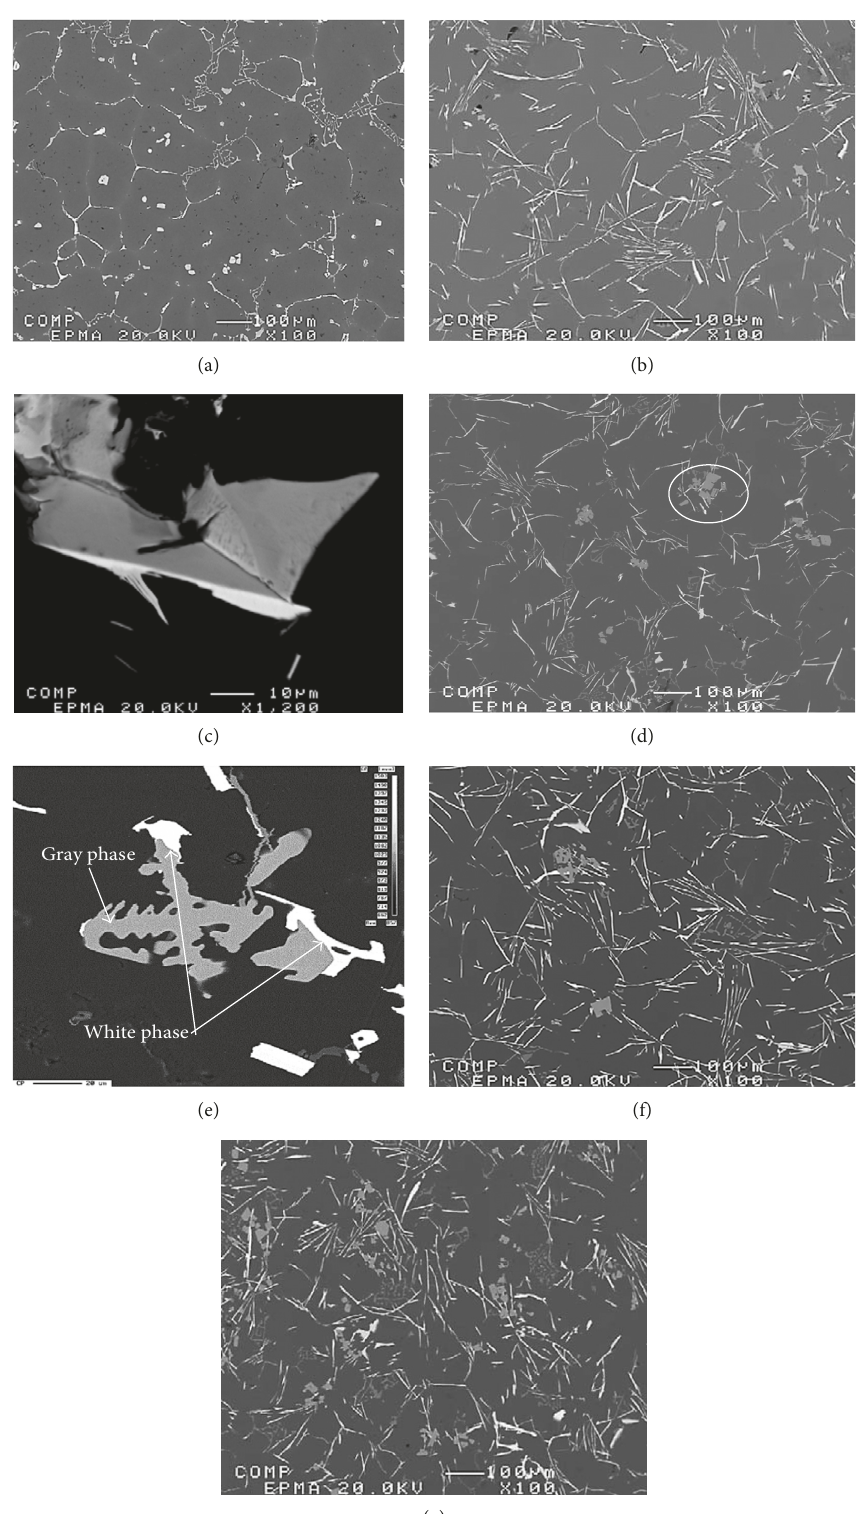
Figure 7: Backscattered electron images of (a) B0-based alloy; (b) B0 +5%La; (c) La-rich platet in (b); (d) B0+5%La +0.2%Ti; (e) high magnification micrograph of the gray phase circled in (d); (f) B0+5%Ce; (g) B0+ 5%Ce+0.2%Ti